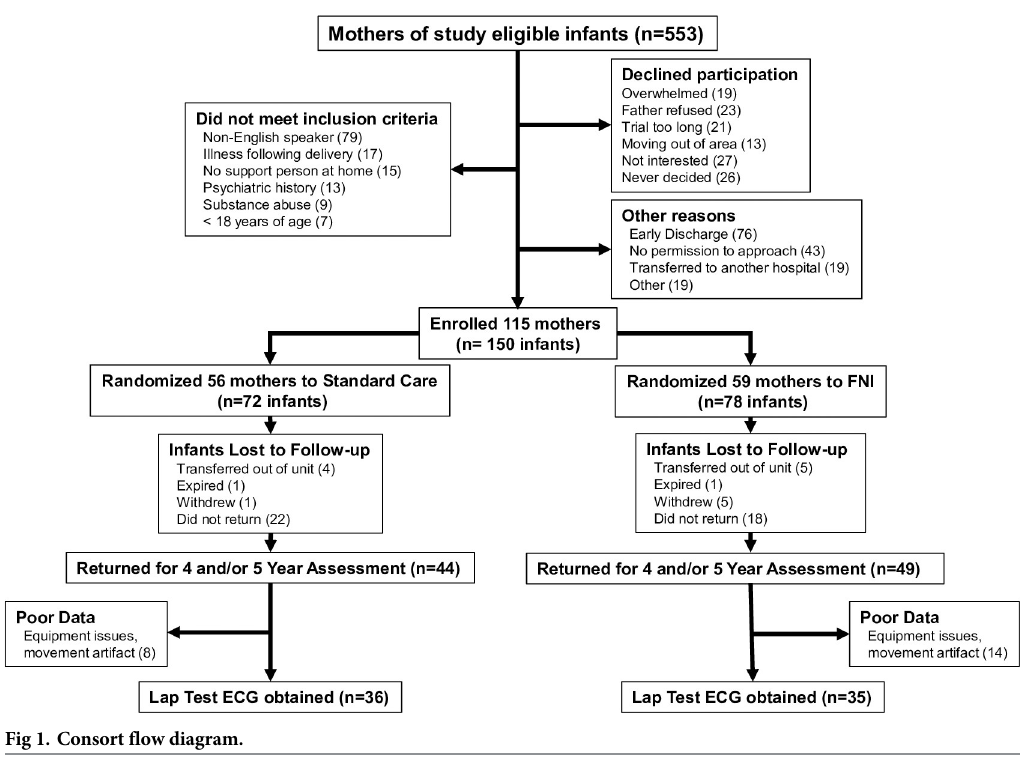
Fig 1. Consort flow